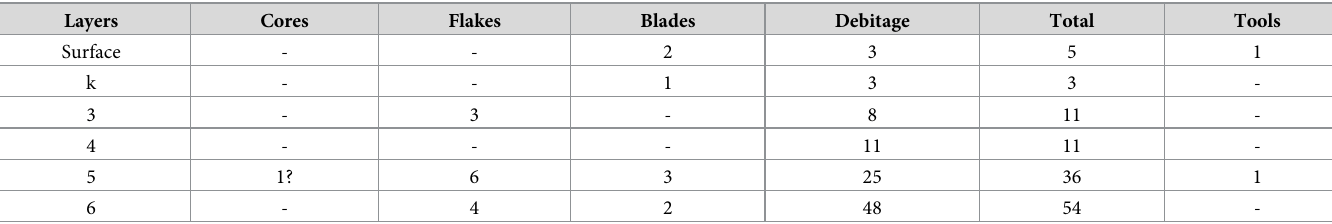
Table 7. Lithic assemblage from zone 3. Finds from the surface layer date mainly to the Holocene. Layers k to 6 all date to the Middle Palaeolithic.